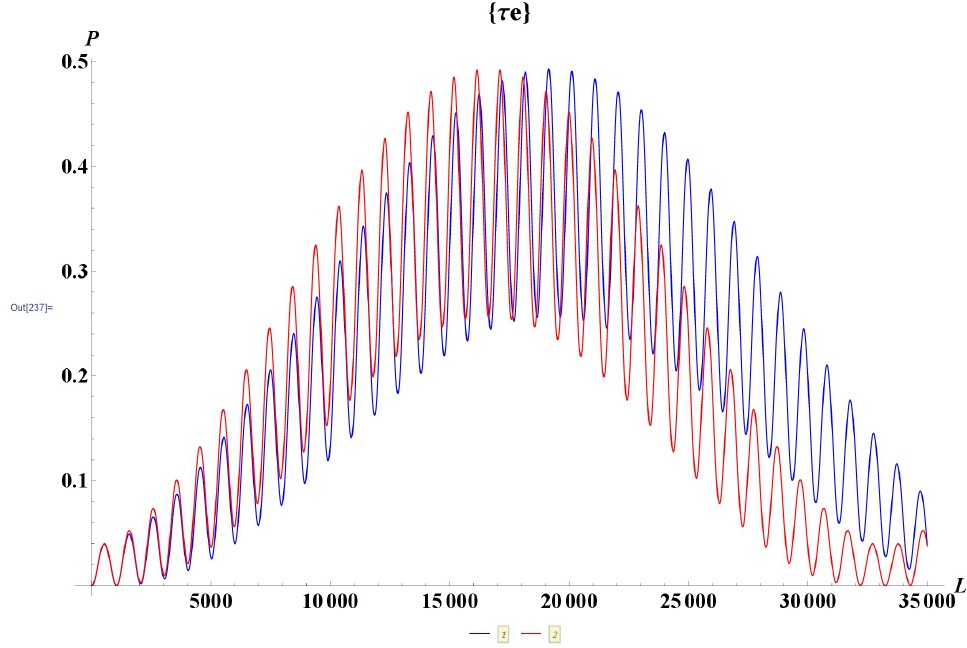
Figure 3. Same analysis of Figure 1, but for the oscillation ν e → ν τ . Baseline L in km [73].